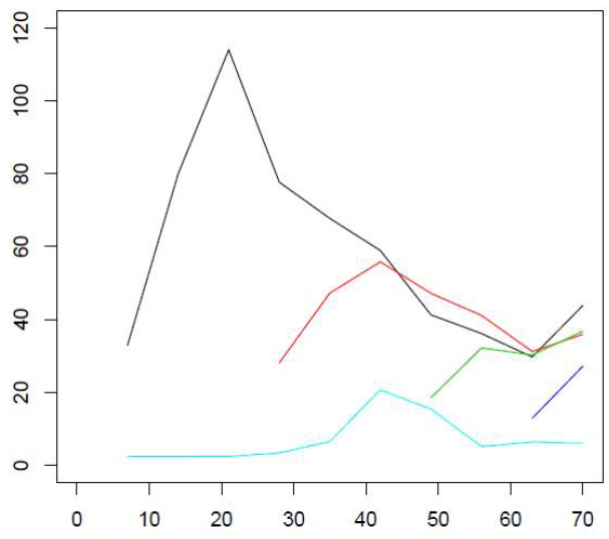
Fig 1 .Number of eggs (black line), larvae (red line), pupae (green line), adults (dark blue line) and concentration of CO during a period of 10 weeks, within of a claustral foundation of Atta sexdens